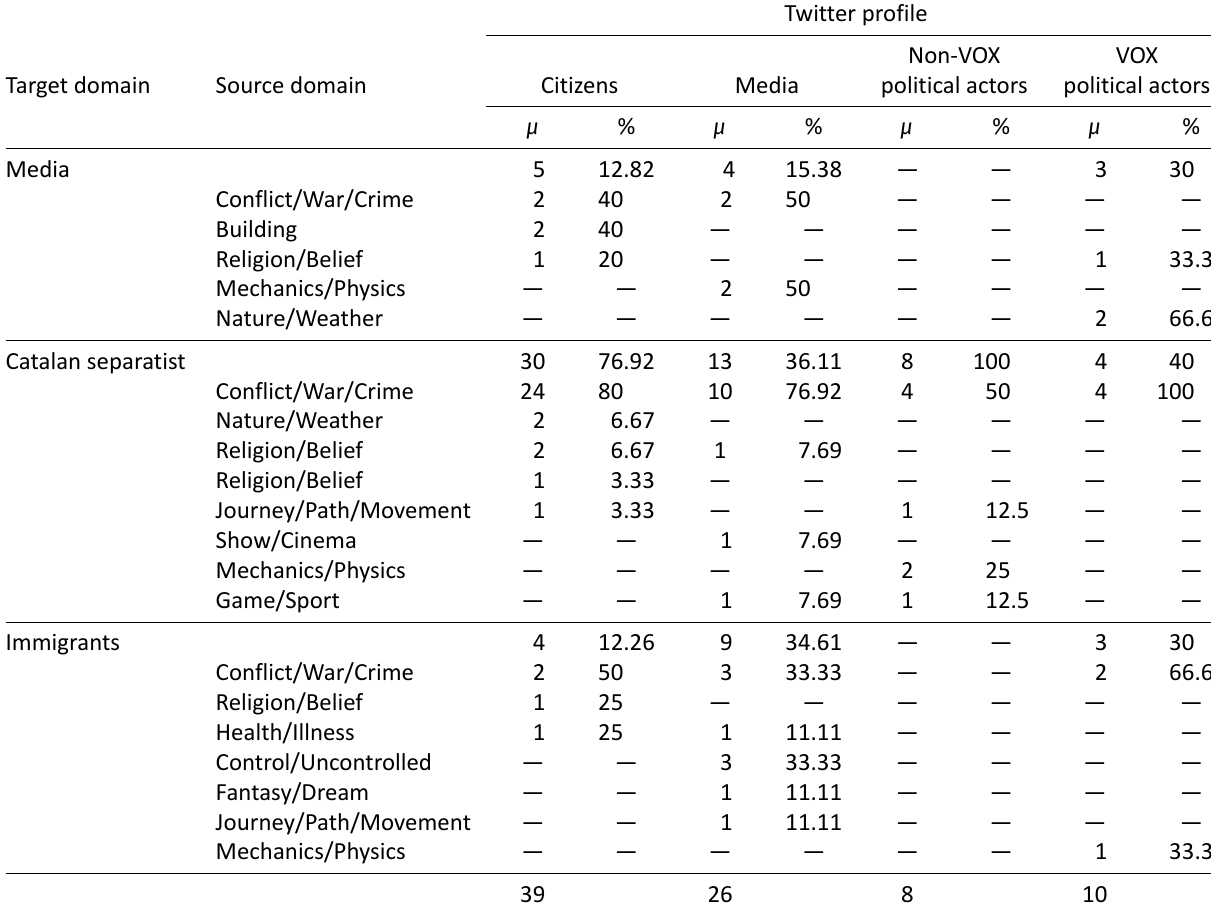
Table 7. Source domains used by Twitter profile to refer to the